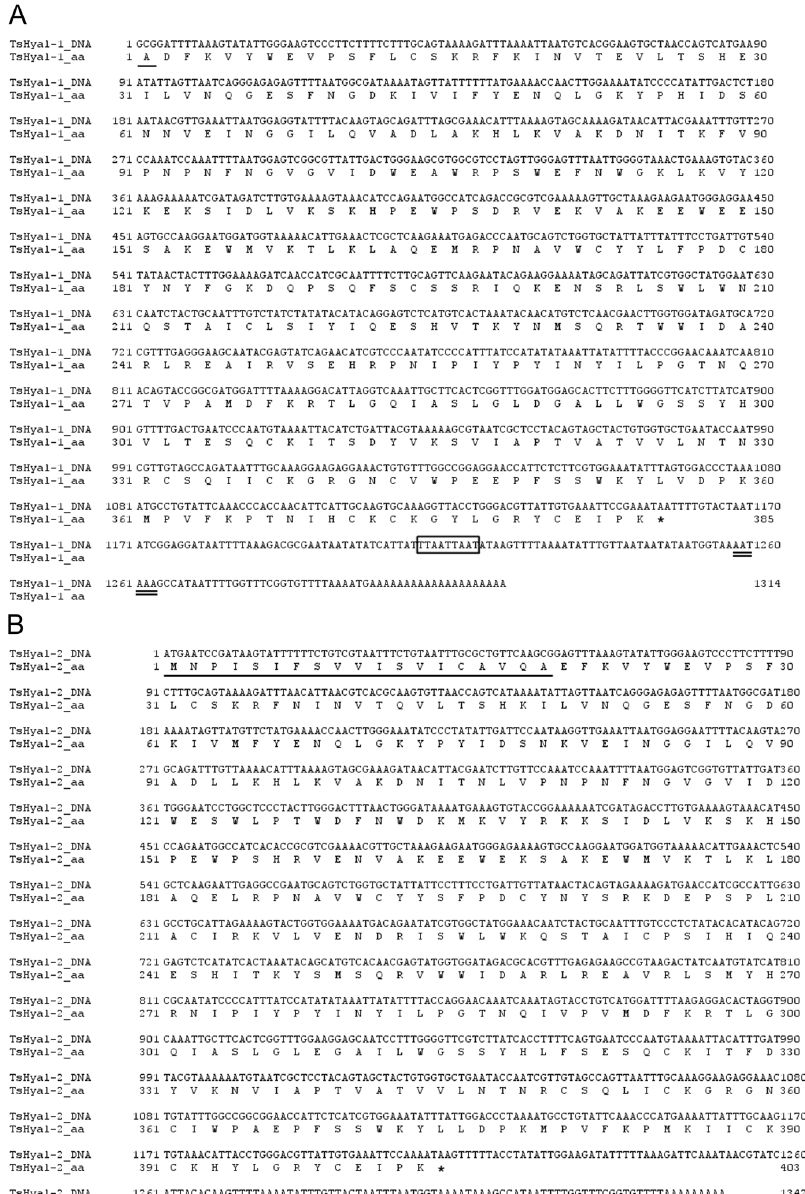
Figure 1. Nucleotide and amino acid sequences of hyaluronidase isoforms from Tityusserrulatus venom. cDNA and predicted amino acid sequences of (A) TsHyal-1 and (B) TsHyal-2. Stop codons are marked with asterisks, signal peptide sequences are underlined, and polyadenylation signals are double-underlined. The 9-bp insertion/deletion in TsHyal-1 is boxed. doi:10.1371/journal.pntd.0002693.g001 SPOT peptide immunoassay